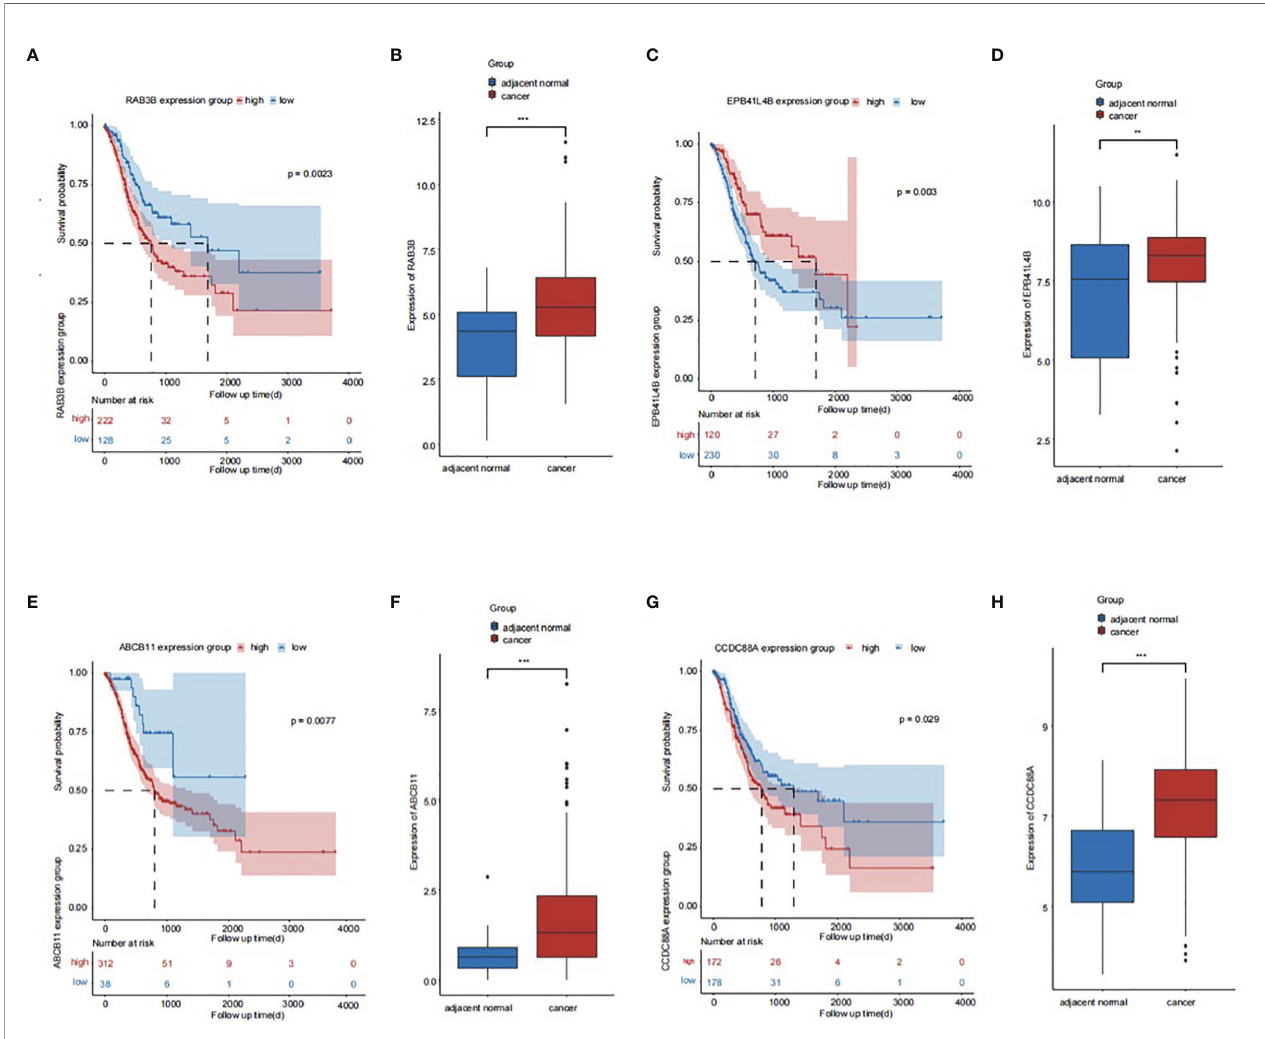
FIGURE 6 | The association of genes in the ceRNA network and prognosis of gastric cancer (GC) patients. (A) The association of RAB3B and prognosis of GC patients. (B) The expression of RAB3B in GC tissues. (C) The association of EPB41L4B and prognosis of GC patients. (D) The expression of EPB41L4B in GC tissues. (E) The association of ABCB11 and prognosis of GC patients. (F) The expression of ABCB11 in GC tissues. (G) The association of CCDC88A and prognosis of GC patients. (H) The expression of CCDC88A in GC tissues. ** p < 0.01, *** p <